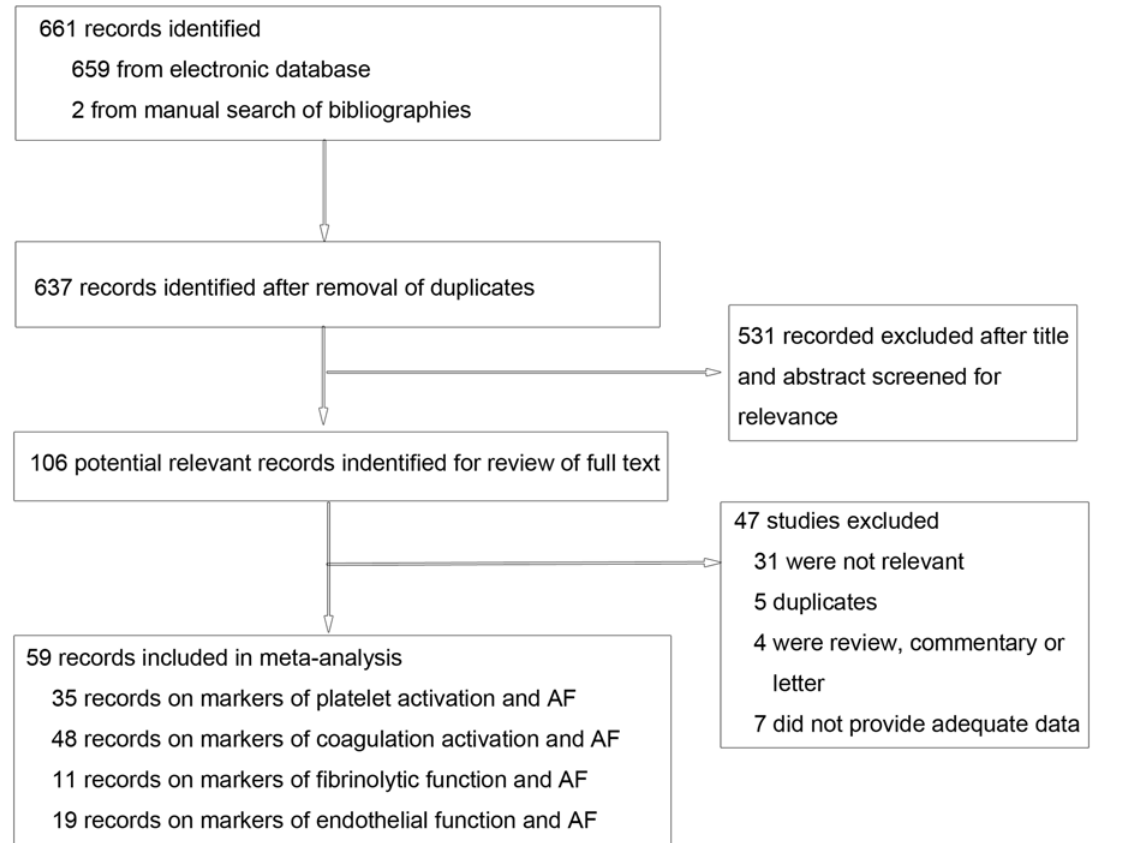
Fig 1. Flow diagram of the literature search and study